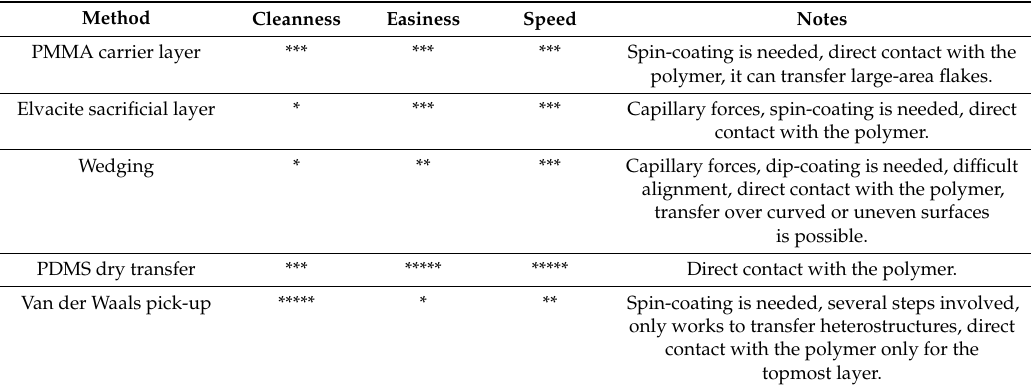
Table 5. Comparison between the di ff erent deterministic placement methods. Qualitative comparison in terms of cleanness, easiness, and speed between the di ff erent deterministic placement methods described in the text. Comments about their main drawbacks are also included in the